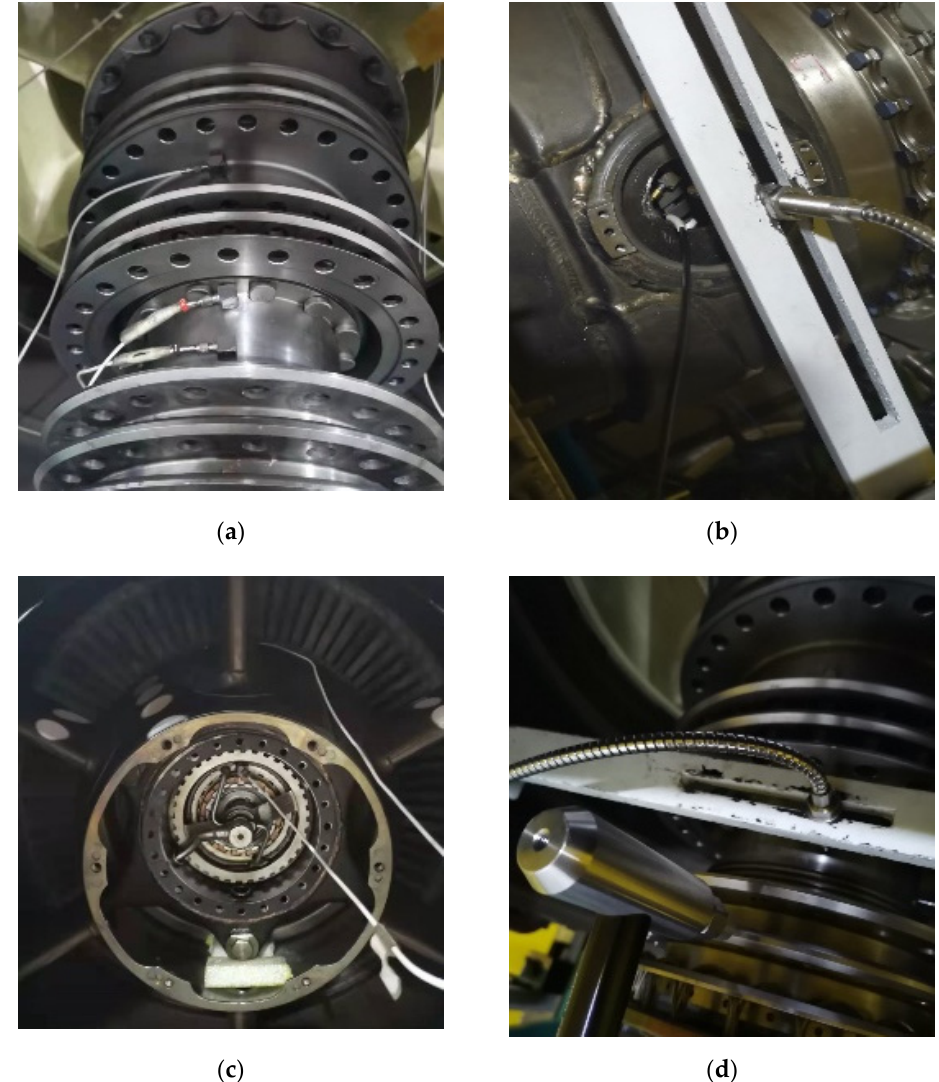
Figure 6. Sensor measuring point arrangement for dual-rotor system of aero-engine: ( a ) Measuring points of the low-pressure compressor; ( b ) Measuring points of the high-pressure compressor; ( c ) Measuring points of the rear supporting of the low-pressure turbine; ( d ) Measuring points of the force hammer.